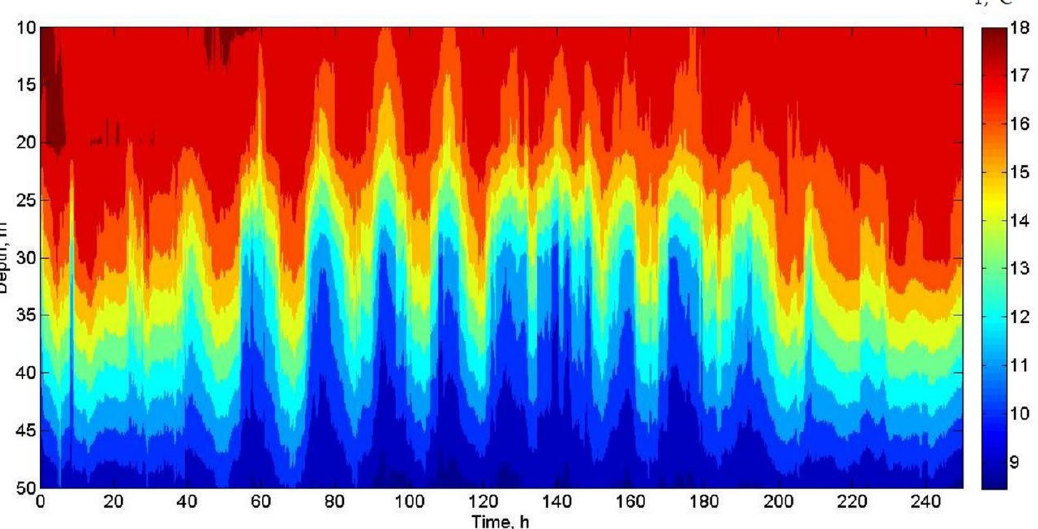
Figure 2. The record of a moored thermistor string near Cape Sukhumsky from 3 November to 13 November 2013 shows inertial internal waves with amplitudes up to 15–20 m.